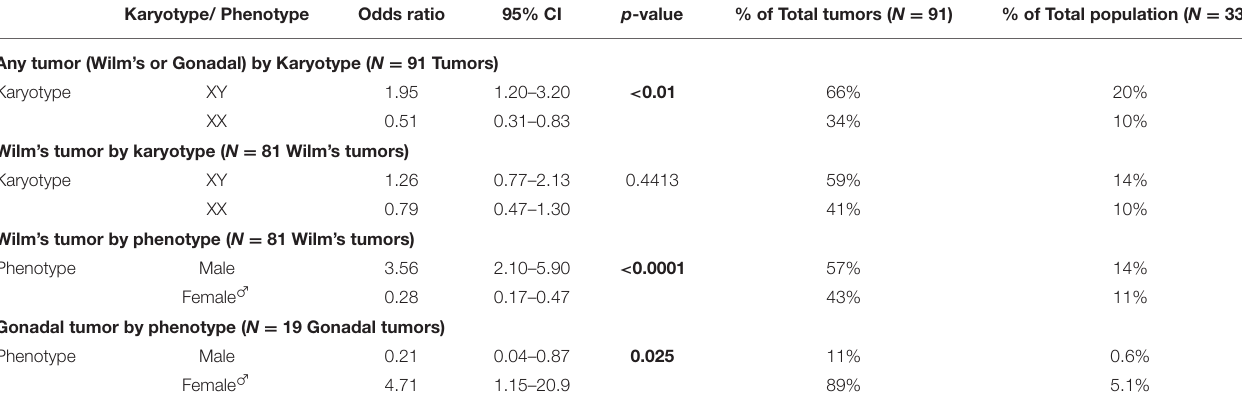
TABLE 4 | Online: Odds ratios for risks of malignancy in WT1 mutation according to phenotype–karyotype in a case series of 333 subjects.